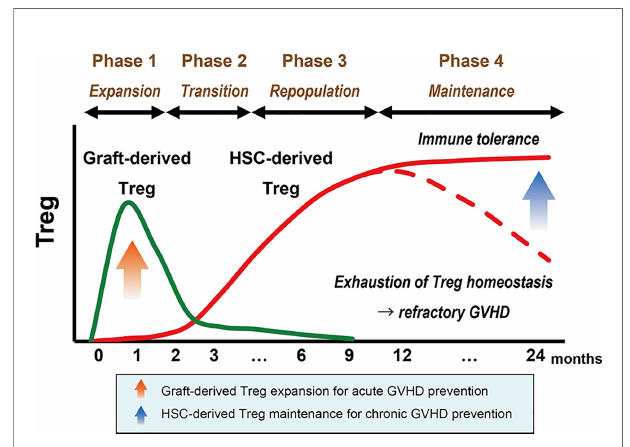
FIGURE 3 | Basic framework of Treg reconstitution after HSCT. The basic framework of Treg recovery after HSCT consists of four phases. In the fi rst month after HSCT, lymphopenia-driven peripheral proliferation of graft-derived Tregs (shown in green) induces the initial expansion of this subset, which is important for preventing acute GVHD (Phase 1). The total number of Tregs transiently decrease between the contraction of expanded graft-derived Tregs and the emergence of HSC-derived Tregs (shown in red) (Phase 2). Prolonged lymphopenia in the fi rst year promotes the continuous aggressive proliferation of HSC-derived Tregs, which contributes to the recovery of total Treg cells and provides an essential basis for long-term immune tolerance (red solid line) (Phase 3). However, highly proliferative Tregs can fail to maintain homeostasis due to the high susceptibility to apoptosis, and exhaustion of the Treg population could be a trigger for refractory GVHD (red dotted line) (Phase 4). GVHD, graft- versus -host disease; Treg, regulatory T cell; HSC, hematopoietic stem